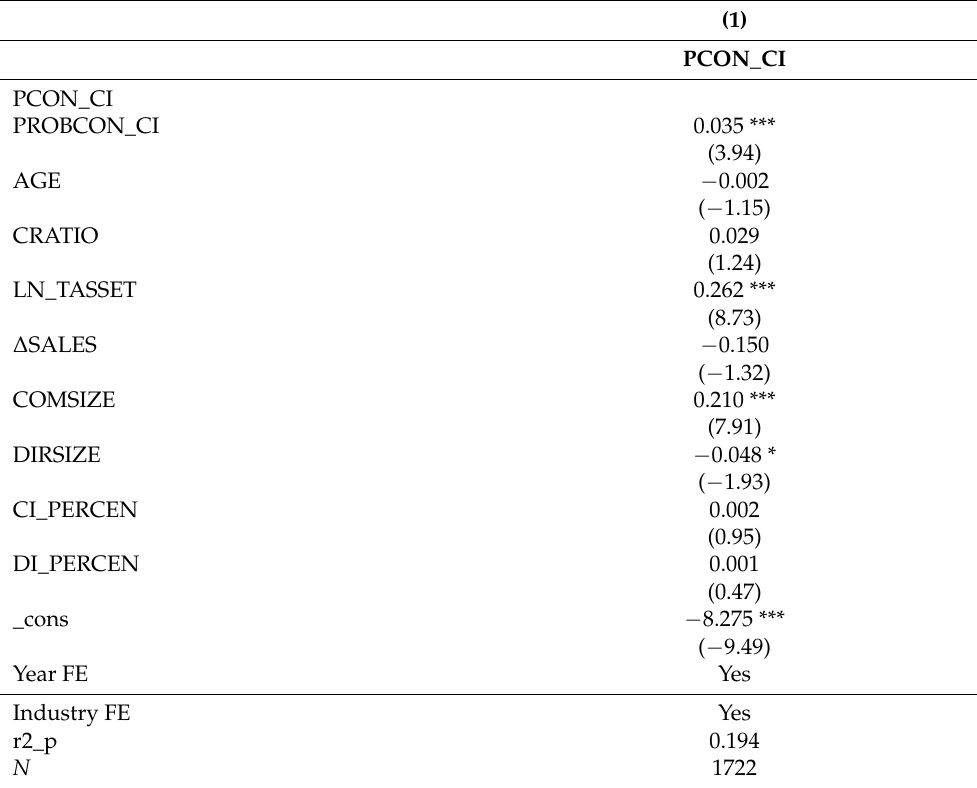
Table 9. Fist-Stage Regression Model Results: Determinants of Firm Political Connections From